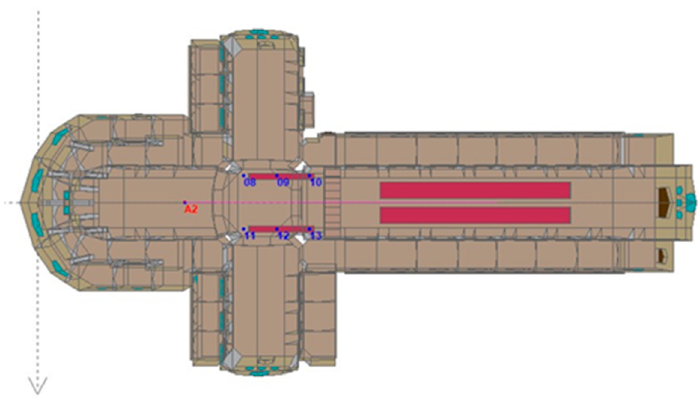
Figure 6. Sound source and receivers from the altar to the quire area.